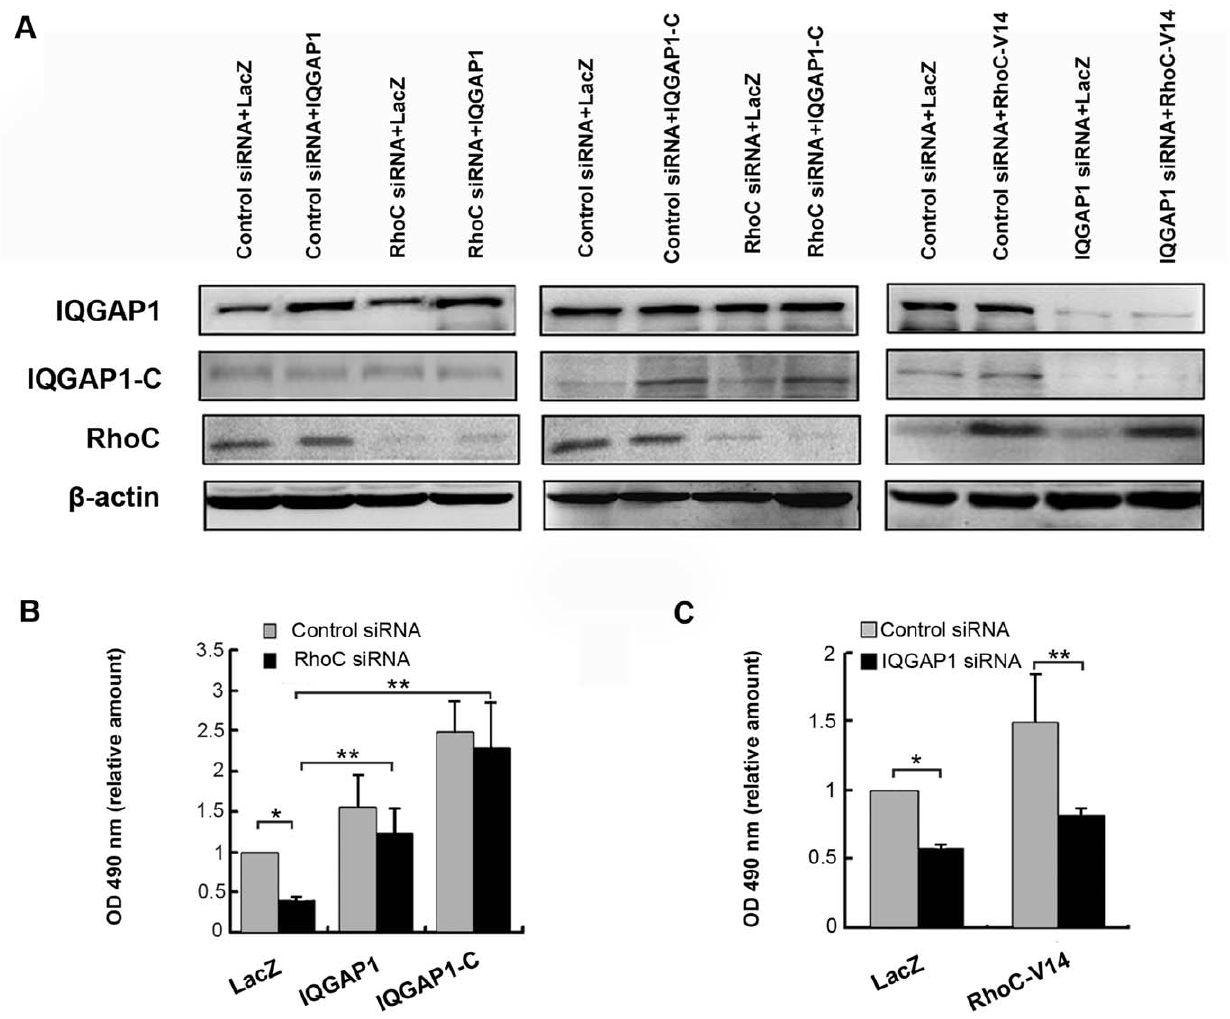
Figure 3. The proliferation-stimulating effect of RhoC was blocked by IQGAP1 siRNA. ( A ) The protein expression levels of IQGAP1, IQGAP1-C and RhoC in BGC-823 cells. BGC-823 cells were transiently transfected with IQGAP1 siRNA or RhoC siRNA for 24 h. The transfected cells were afterwards infected with Ad-RhoC-V14, Ad-IQGAP1-C or Ad-IQGAP1 for additional 48 h followed by Western blotting. ( B ) RhoC depletion did not significantly affect IQGAP1 or IQGAP1-C induced proliferation of BGC-823 cells. ( C ) The silencing of IQGAP1 by siRNA markedly inhibited the RhoC-induced cell proliferation in BGC-823 cells. (MTT assay, *P , 0.05; **P , 0.01). The data are the means 6 SD from three independent experiments each performed in